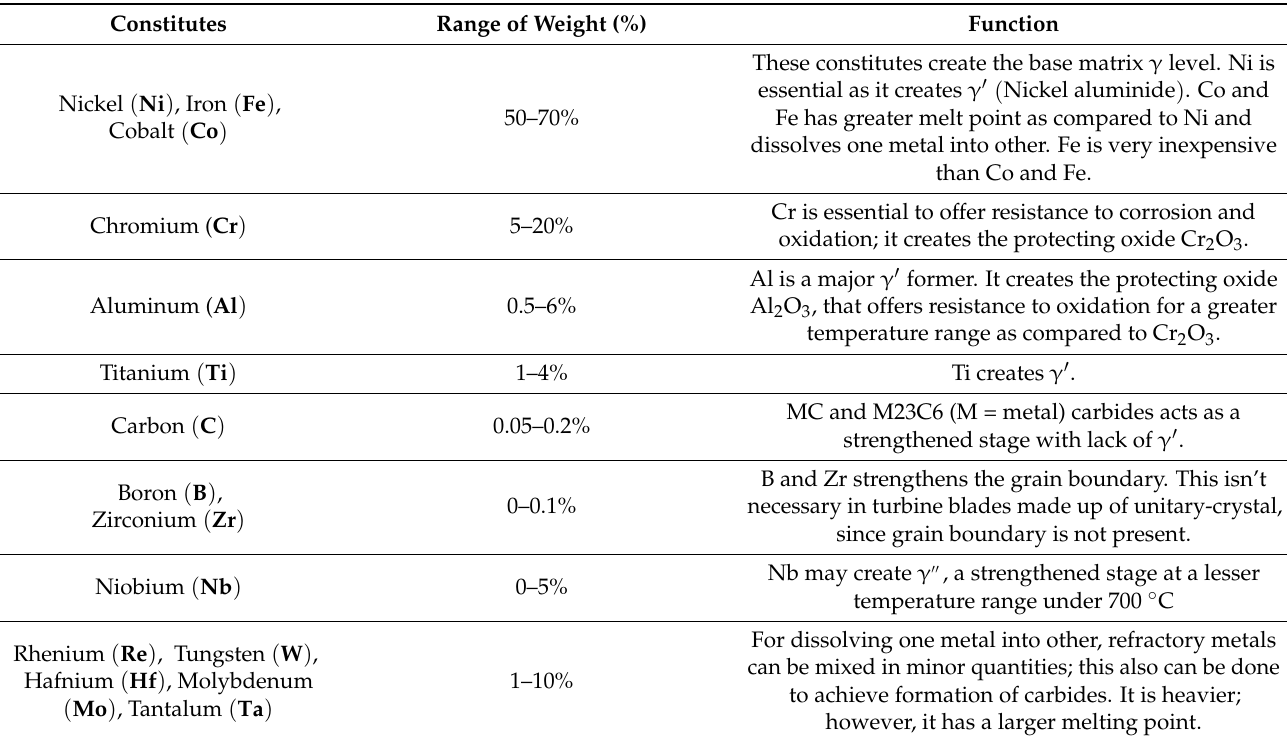
Table 1. Combinations of nickel-based superalloys.